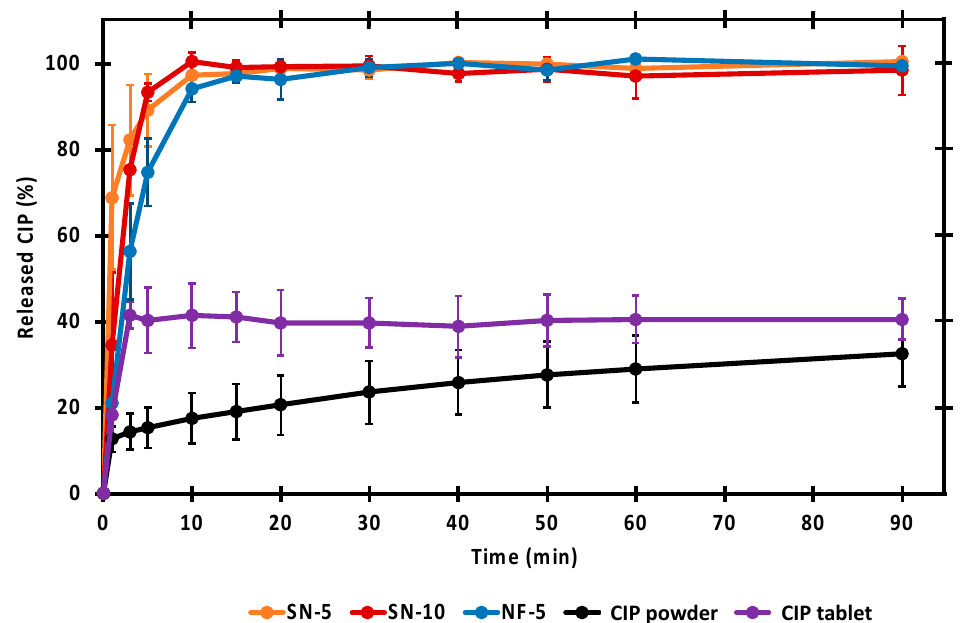
Figure 6. In vitro dissolution of ciprofloxacin (CIP) from the nanofibrous samples, CIP powder, and tablet. Nearly the total amount of CIP was rapidly released from the nanofibers prepared via single-nozzle (SN-5 and SN-10) and nozzle-free (NF-5) electrospinning.